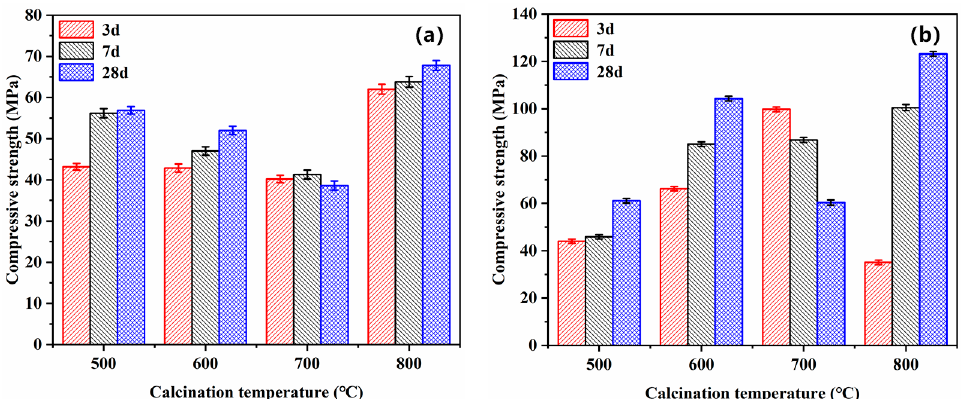
Figure 10. Effect of Baume and the calcination temperature of magnesium residue on the compressive strengths of MOC: ( a ) 24 Baume ( b ) 28 Baume.